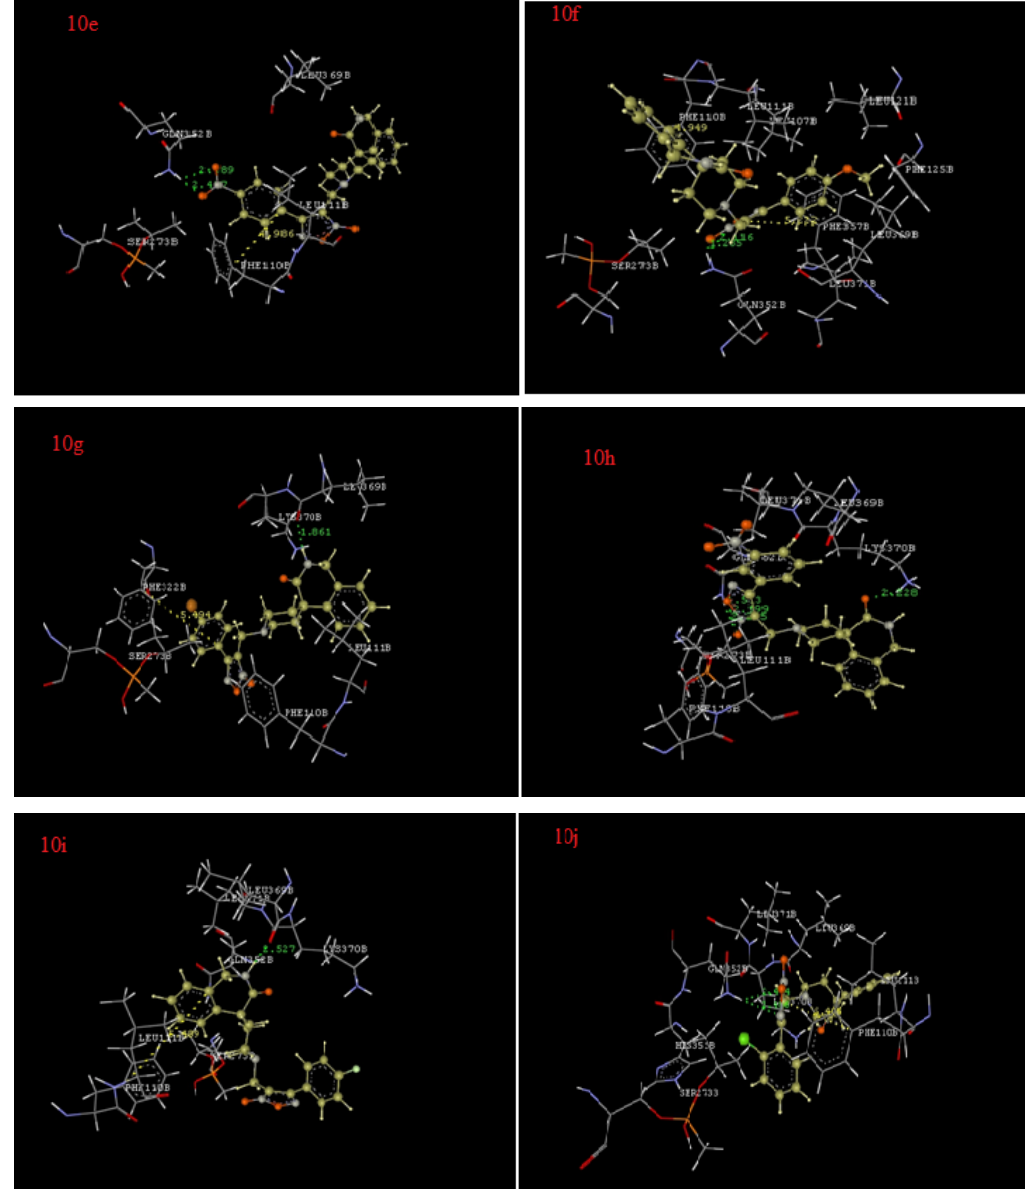
Figure 2. Interactions of 10a – j with phosphodiesterase V.